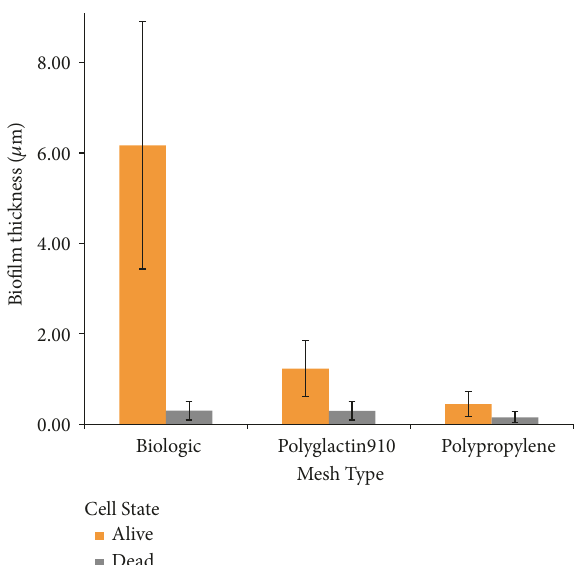
Figure 4: Biofilm Thickness after 24 hr Exposure to MRSA. Quantification of biofilm thickness, orange bars represent viable bacteria and light grey bars nonviable bacteria.